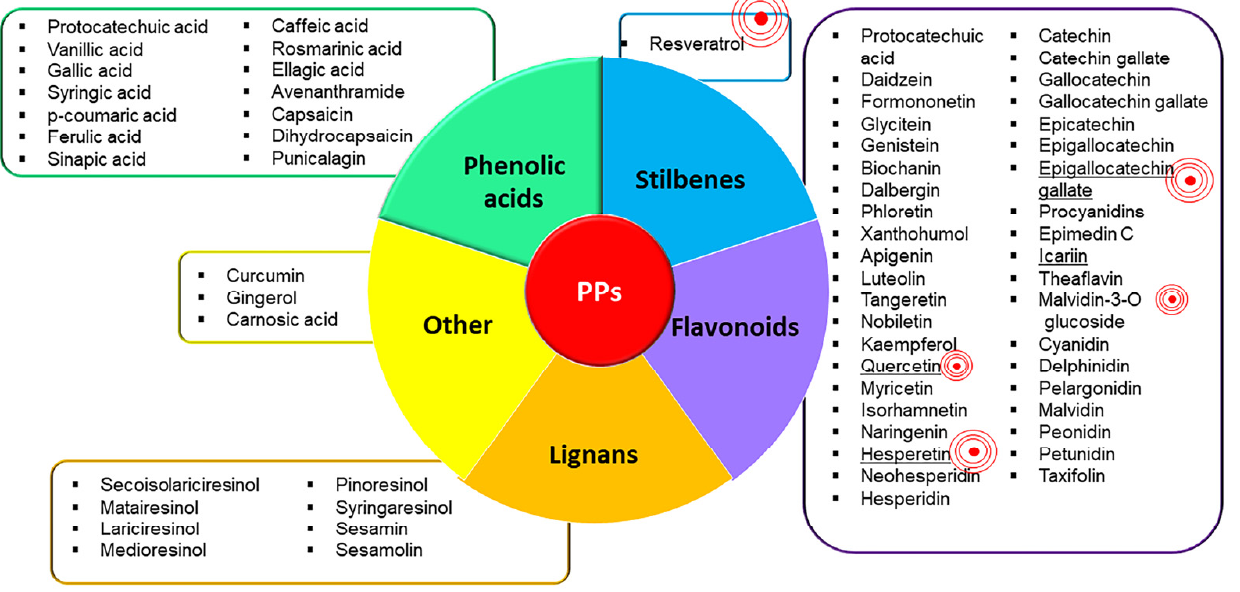
Figure 1. PPs classification. Figure 1 shows the known classes of PPs and the main PPs which constitute each class. The two classes of PPs most represented are flavonoids and phenolic acids. The ‘red concentric symbol’ highlights the most studied PPs in the field of OA inflammation and pain; its size corresponds to the number of studies. Overall, the most studied is resveratrol, followed by epigallocatechin gallate, quercetin, icariin, and hesperetin. To the best of our knowledge the